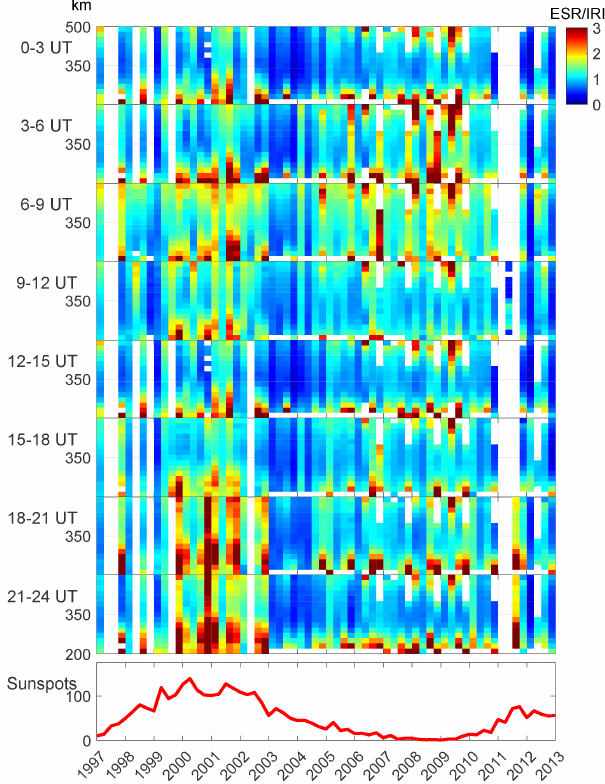
Figure 3. Altitude profiles of the ratio between ESR and IRI elec- tron densities. The eight top panels correspond to the different 3h integration intervals. The last panel shows the 3-month averaged sunspot number. The four columns for each year represent the sea- sons in the order of spring, summer, autumn and